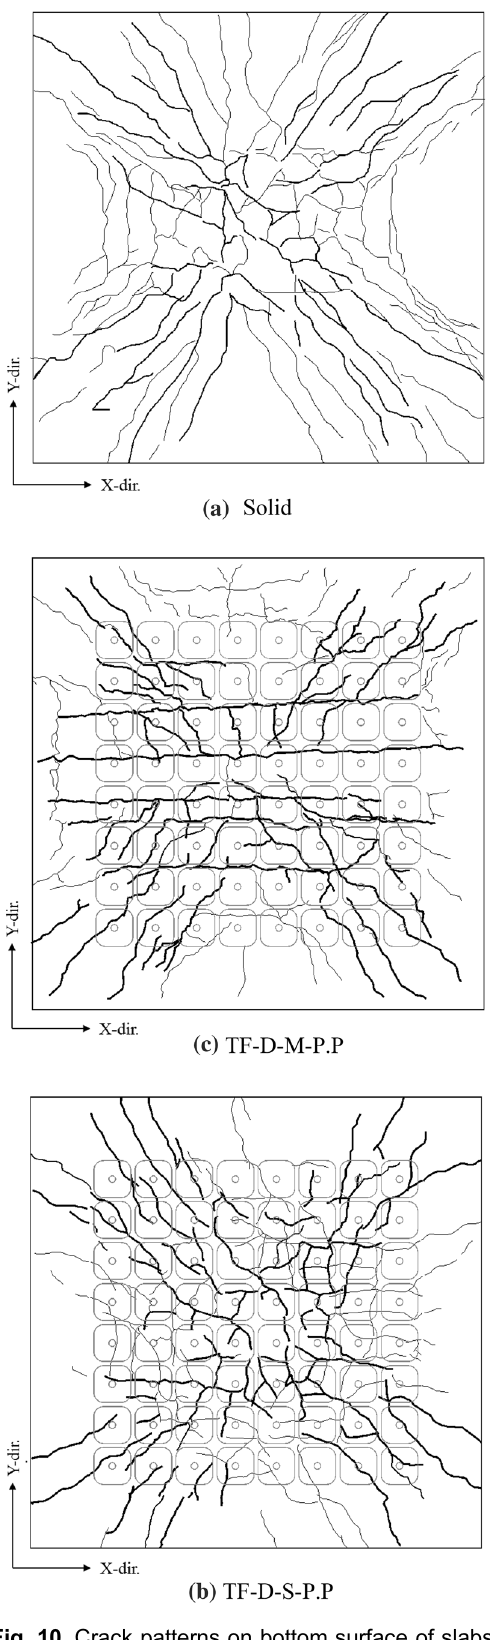
Fig. 10 Crack patterns on bottom surface of large in comparison to that of the solid slab, as shown in Fig. 10b.